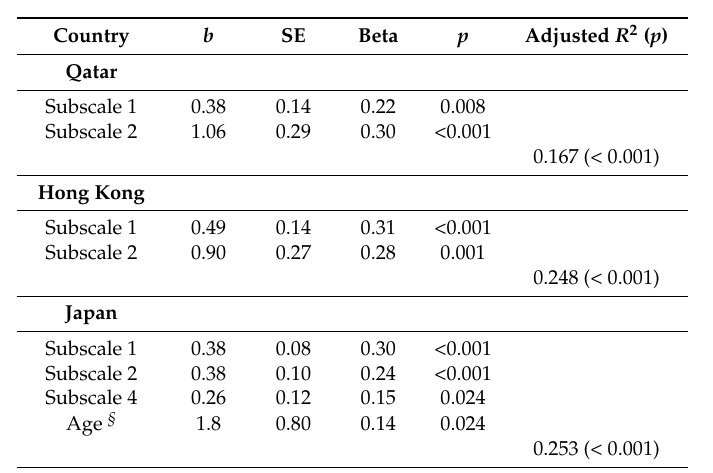
Table 5. Results from stepwise linear regression models–PHASe subscale and other significant predictors of MHN involvement in physical health-care